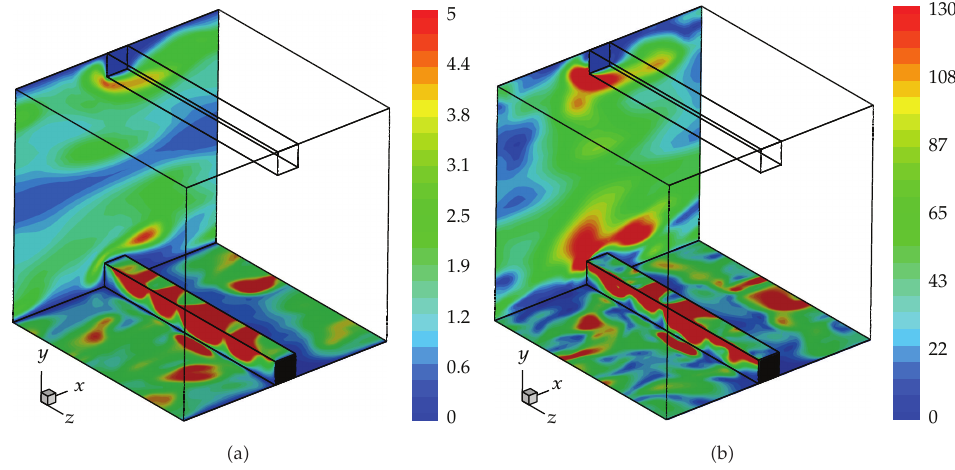
Figure 5: Instantaneous contours of (cid:2) a (cid:3) normalized Nusselt number (cid:2) Nu/Nu 0 (cid:3) and (cid:2) b (cid:3) skin friction coe ffi cient scaled with Reynolds number (cid:2) C f × Re (cid:3) on one of the sidewalls and bottom ribbed walls.